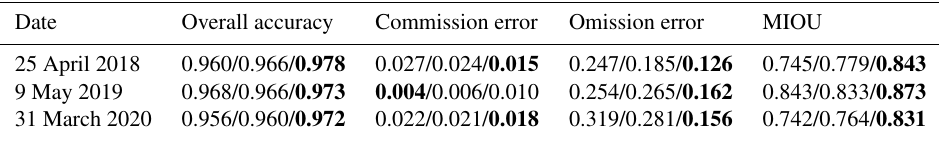
Table 3. Accuracies of the lead maps obtained by different methods using data acquired on different dates.